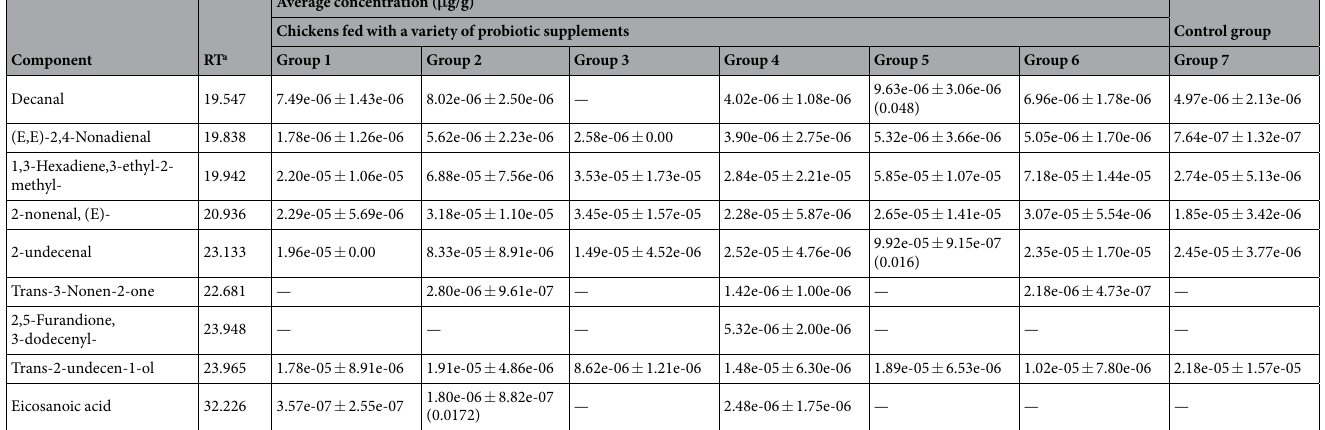
activity and trypsin activity of Group 2 was all significantly increased compared to control Group 7 (P = 0.014, 0.019 and P = 0.023). For the duodenum, only the lipase activities in Group 2, 3 and 6 were significantly higher than control Group 7 (P = 0.036, 0.033 and 0.024), but the amylase activity and trypsin activity in all probiotic experiment groups had no significant differences compared to control Group 7 (P > 0.05). Sequences and taxonomic composition. The hypervariable V3 region of 16S rDNA genes was sequenced from caecum samples of individuals with probiotic treatment (n = 12) and the control group (n = 3). A total of 247,658 high-quality and classifiable reads were generated from all samples, and the number of sequences in each group varied from 34,803 to 35,957 (median = 35,379). A total of 15,074 operational taxonomic units (OTUs) were identified at the 97% sequence similarity level with high threshold identity and with an average of 2153 OTUs for each group sample. For all samples, rarefaction curves (Supplementary Figure S2) showed an increasing trend in trial groups (Group1 to Group 6) over the control group (Group 7), but the difference did not reach statistical significance. The rarefaction curves indices were highest in Group 6. This suggested that the microbial diversity of trial groups was higher than in the control group. The Shannon and Simpson indices were applied to evaluate the diversity of gut microbiota, while the Chao1 and ACE was an indicator of species abundance. The results from the analysis of the alpha diversity metrics showed that except for Group 5, the Shannon and npShannon indices of probiotic-treated groups was increased, but Simpson index was decreased compared with control Group 7. In addition, Chao 1 and ACE displayed sig- nificantly higher index in Group 3 and Group 6 than the control Group 7 (P = 0.016, 0.023, 0.021, 0.018, respec- tively) (Table S3), these results suggest that probiotic additions to diet may result in an increase in the diversity of chicken intestinal bacterial flora. The overall microbial composition of the probiotic treatment group and control group differed at the phylum levels (Fig. 2), although none of these differences were statistically significant after multiple test correction. In this study, more than 99.90% of bacterial rDNA sequences were assigned to the domain Bacteria, with more than 99.00% of sequences belonging to five bacterial phyla: Actinobacteria , Bacteroidetes , Cyanobacteria , Firmicutes and Proteobacteria . Similarly, less than 1% of sequences obtained from all the sampled chickens were assigned to the phyla Deferribacteres , TM7 , Tenericutes , and Verrucomicrobia . Firmicutes was the most abundant phylum (60.0–80.3%) in the caecum of chicken in all groups, and its abundance decreased in the probiotic additive group compared to the control group. Bacteroidetes was the second most abundant phyla (17.0–34.4%) in all groups. Unlike Firmicutes , after the experimental diet was supplemented with probiotics, the abundance of Bacteroidetes increased. In addition, the presence of Cyanobacteria was not obvious in caecum; it was only detected in Group 2 (0.13%), Group 3 (0.26%), Group 5 (0.45%) and control group 7 (0.48%). At the genus level, the detected sequences could be assigned to 76 different genera. The most abundant (rel- ative abundance ≥ 1%) suggested the importance of bacteria (Fig. 3). In all trial groups (Group 1 to Group 6) and the control group 7, the Alistipes and Lactobacillus were the dominant genera, representing 10.45%, 4.31%, 24.91%, 23.00%, 26.20%, 5.30%, 14.48% and 10.88%, 12.26%, 8.52%, 9.28%, 1.16%, 12.48%, 30.75% of the total sequences, respectively. Meanwhile, Bacteroides and Faecalibacterium were the second most dominant genera, representing 6.14%, 7.29%, 1.80%, 1.19%, 1.21%, 1.40%, 1.47% and 1.29% and 1.84%, 1.76%, 1.62%, 1.06%, 1.23%, and 1.42% of the total sequences, respectively. Influence of probiotic supplements on development of chicken ceacal microbiome. Principal component analysis (PCA) highlighted a disparity between the probiotic-treated groups and the control group (Group 7) at the bacterial family level (best observed from PC1 (62.7%) and PC2 (27.8%), Fig. 4).